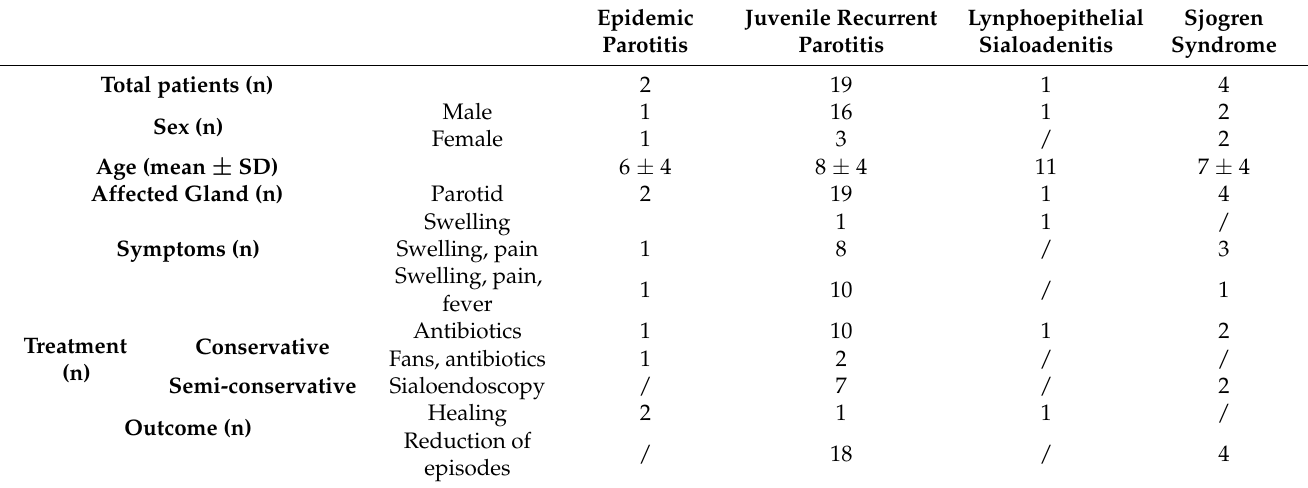
Table 3. The infective, inflammatory and rheumatologic diseases.